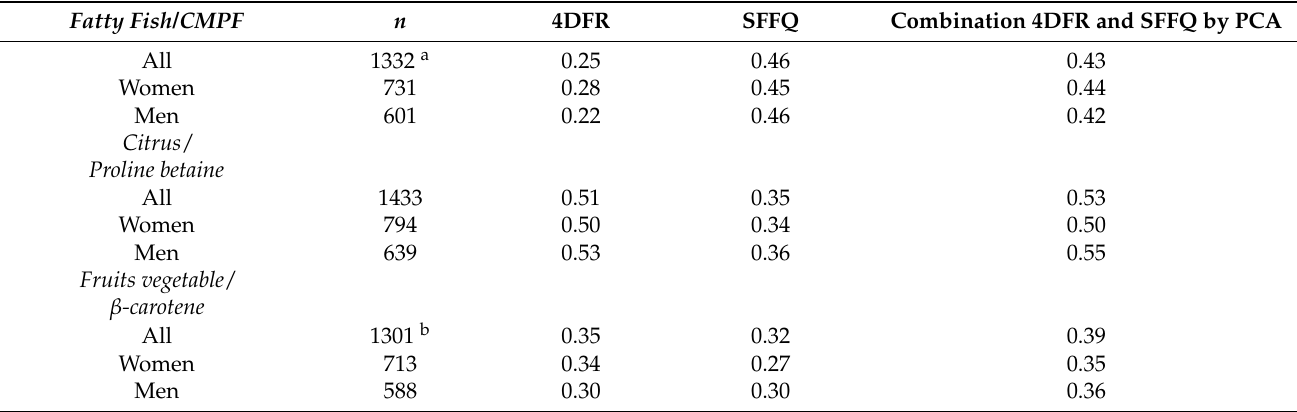
Table 6. Spearman correlations * between fatty fish, citrus and fruits and vegetable intake estimations and the plasma biomarkers 3-carboxy-4-methyl-5-propyl-2-furanpropanoic acid (CMPF), proline betaine, and β -carotene in the Malmö Offspring